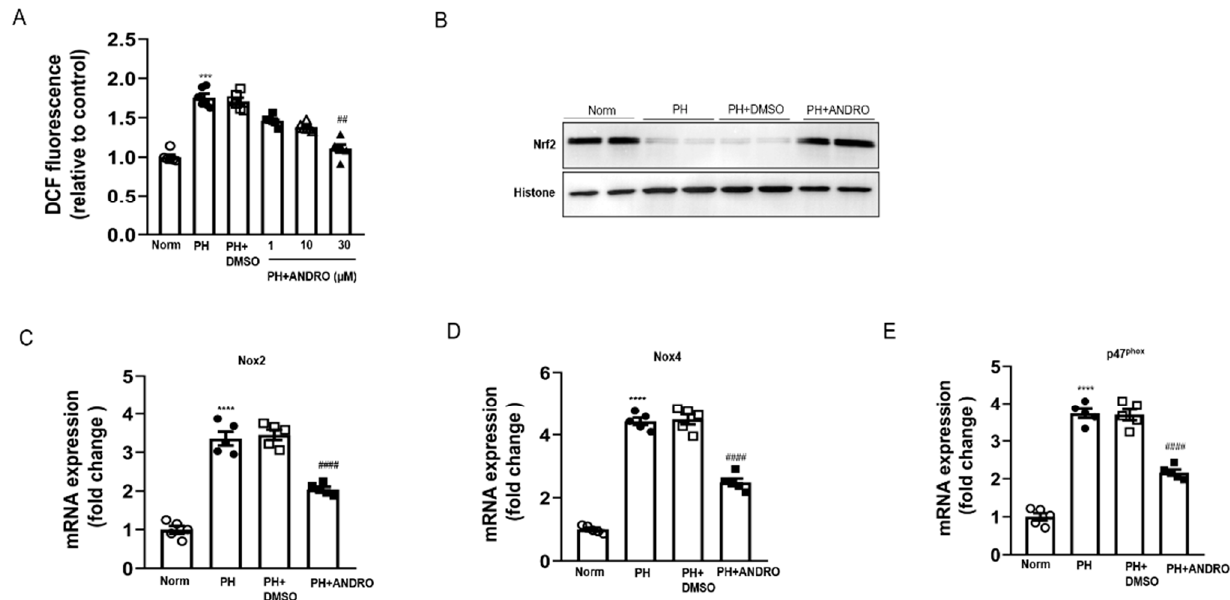
Figure 9. ANDRO treatment blocked ROS generation via regulating NOX/Nrf2 redox imbalance in human PH-PASMCs. ( A ) Intracellular ROS was measured with DCFH-DA probe using confocal microscopy. ANDRO at 30 μ M attenuated ROS production in human PH-PASMCs. ( B ) Representative Western blot analysis showing that ANDRO treatment attenuated the reduced Nrf2 expression during PH. ( C – E ) Real-time PCR analysis showing that ANDRO treatment significantly attenuated the upregulated mRNA levels of NADPH oxidases (NOX2, NOX4, and p47 phox) in PH-PASMCs. *** p < 0.001, **** p < 0.0001, compared to healthy control; ## p < 0.01, #### p < 0.0001, compared to PH-DMSO.